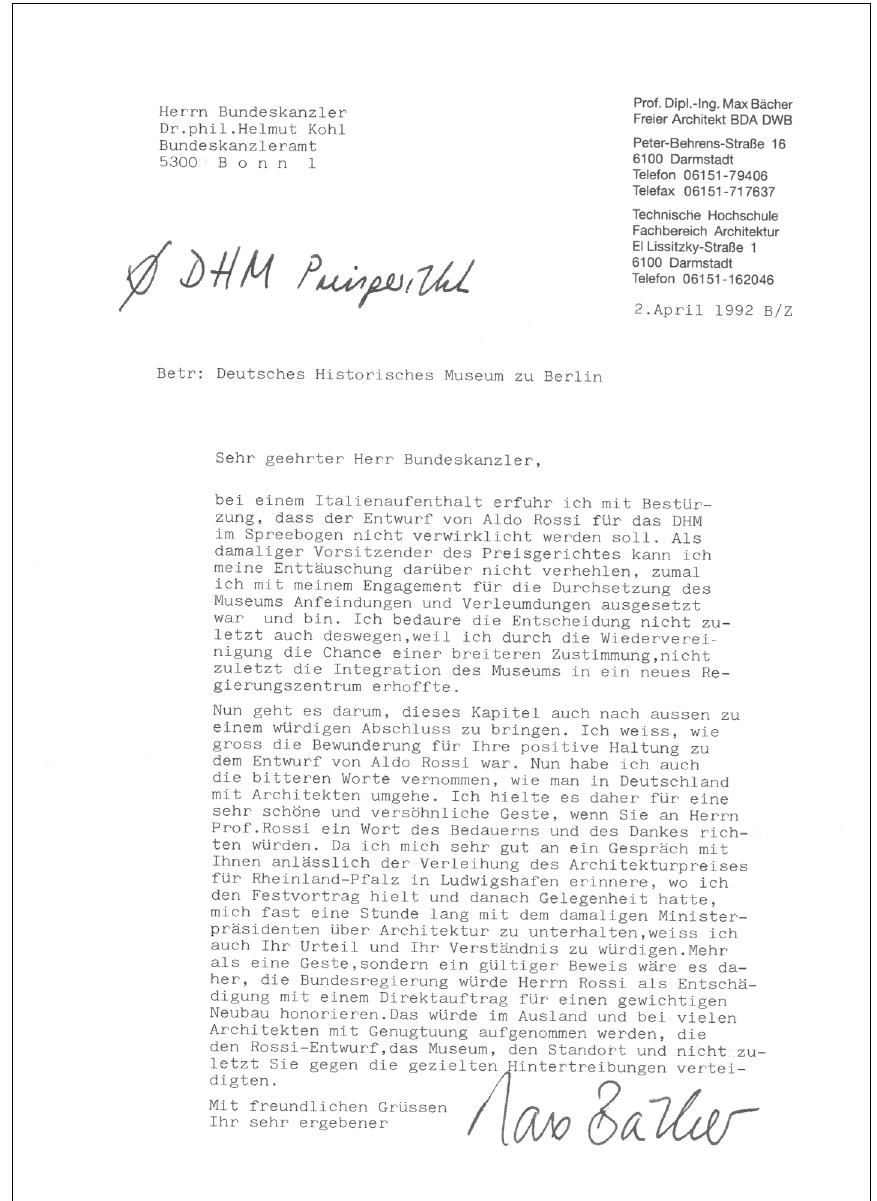
Letter from Max Bächer to chancellor Helmut Kohl from April 2, 1992. (© DAM Archive,